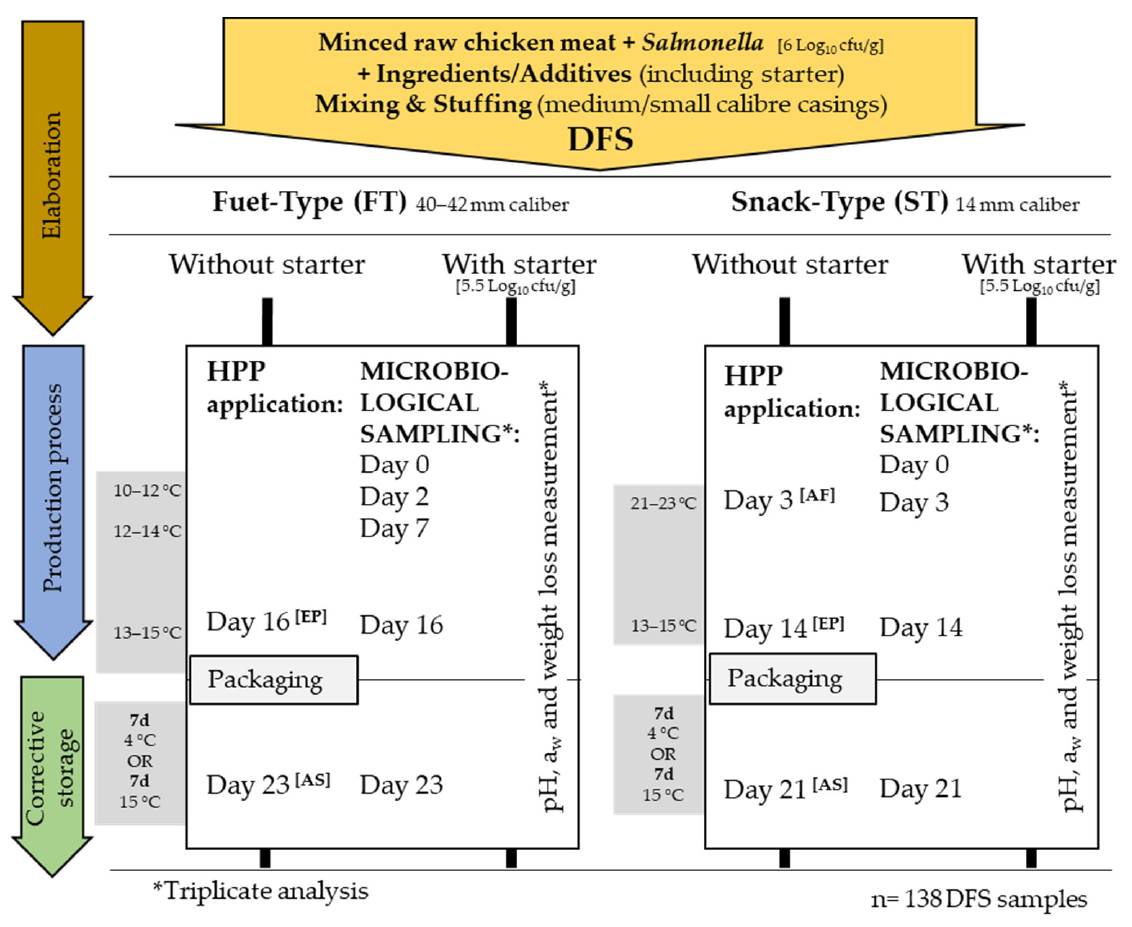
Figure 1. Manufacturing process and experimental design of fuet -type (FT) and snack-type (ST) dry-fermented sausages; n: total number of sampled sausages; d: days; DFS: Dry-Fermented Sausage; HPP: High-Pressure Processing; AF: After Fermentation; EP: End of Process; AS: After Storage.